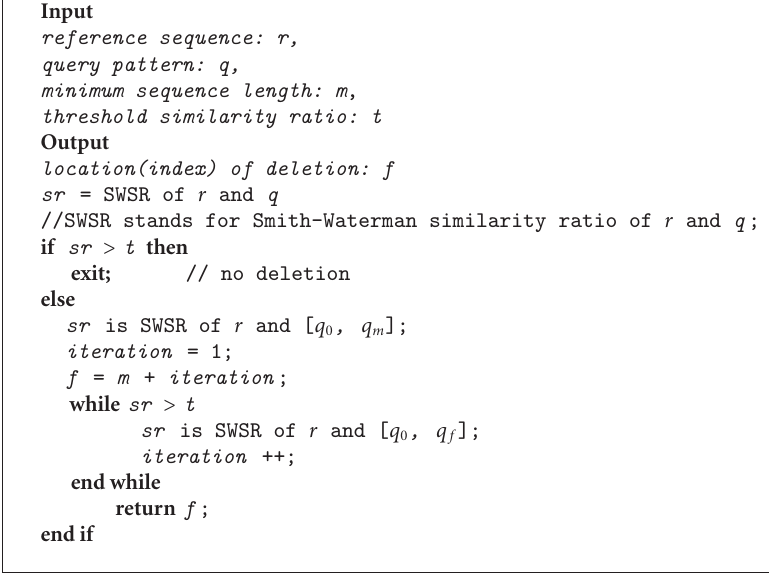
Algorithm 1: IncrementalPartialAlign pseudocode.